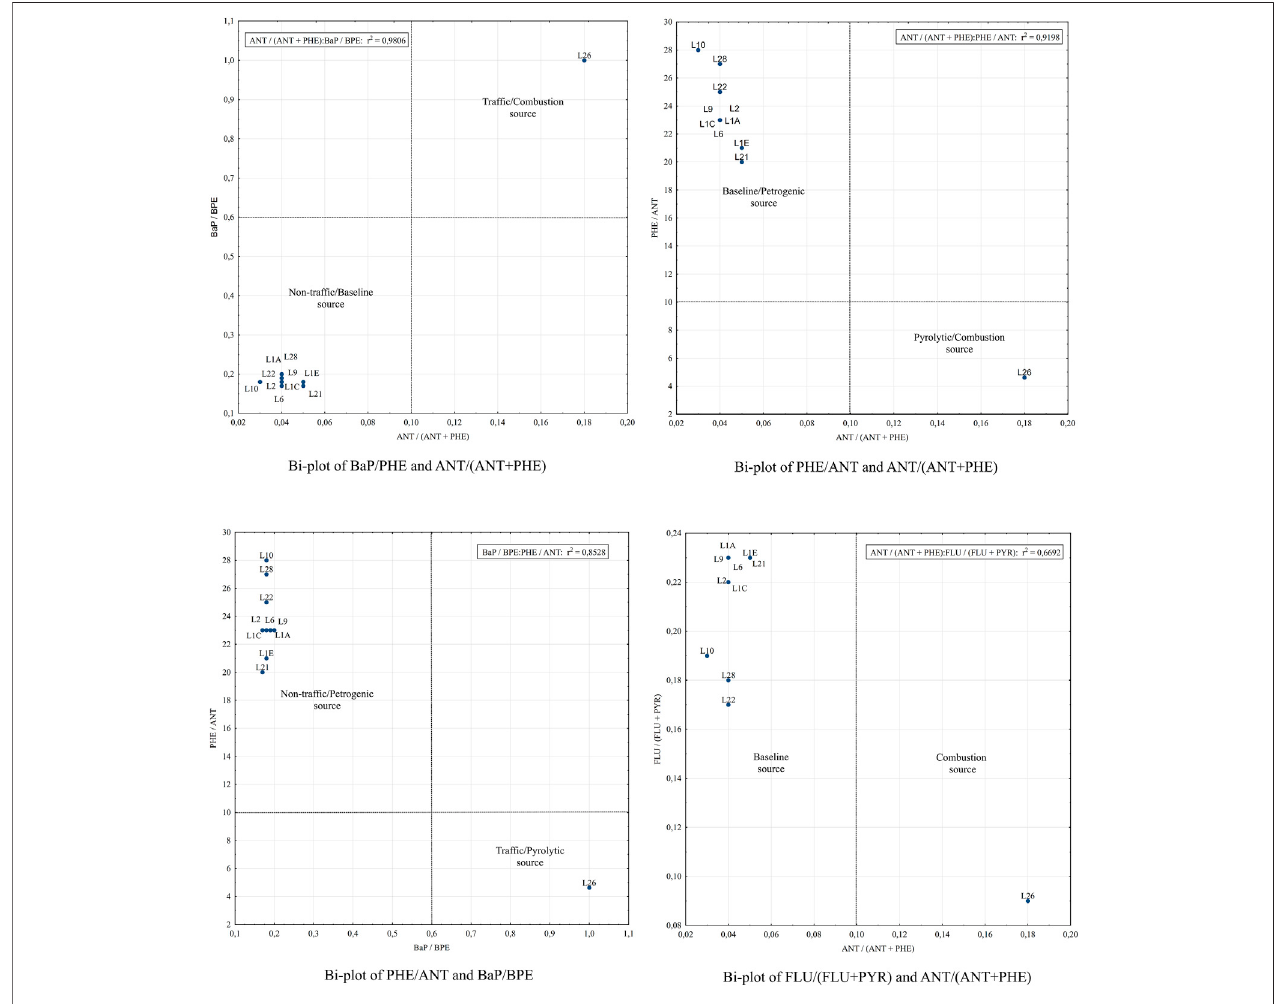
FIGURE 3 | Bi-plots of PAHs isomer